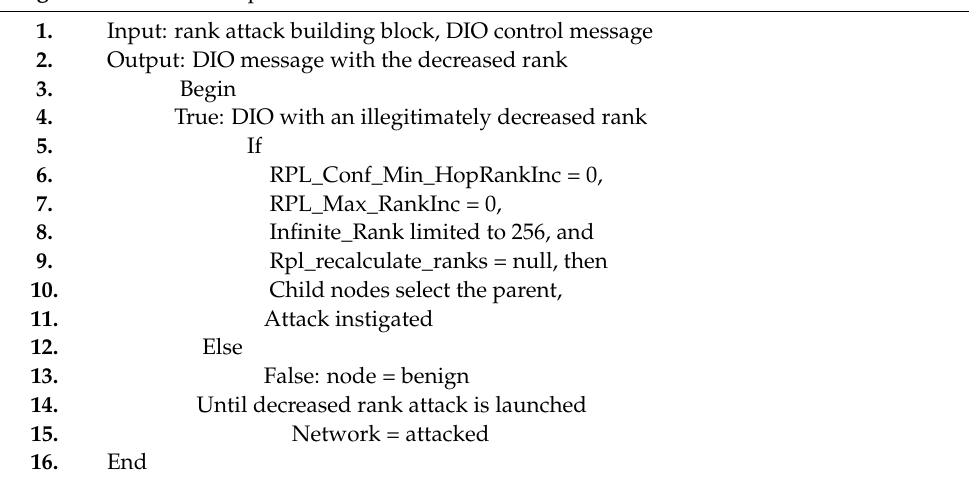
Algorithm 1: Protocol-specific RA